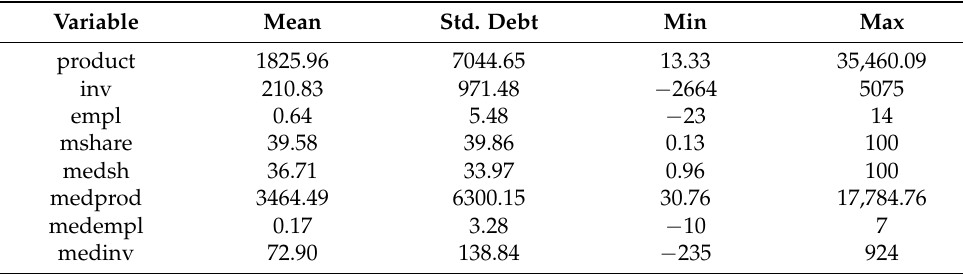
Table 1. Basic statistics, 2016–2020. N = 145. Variable